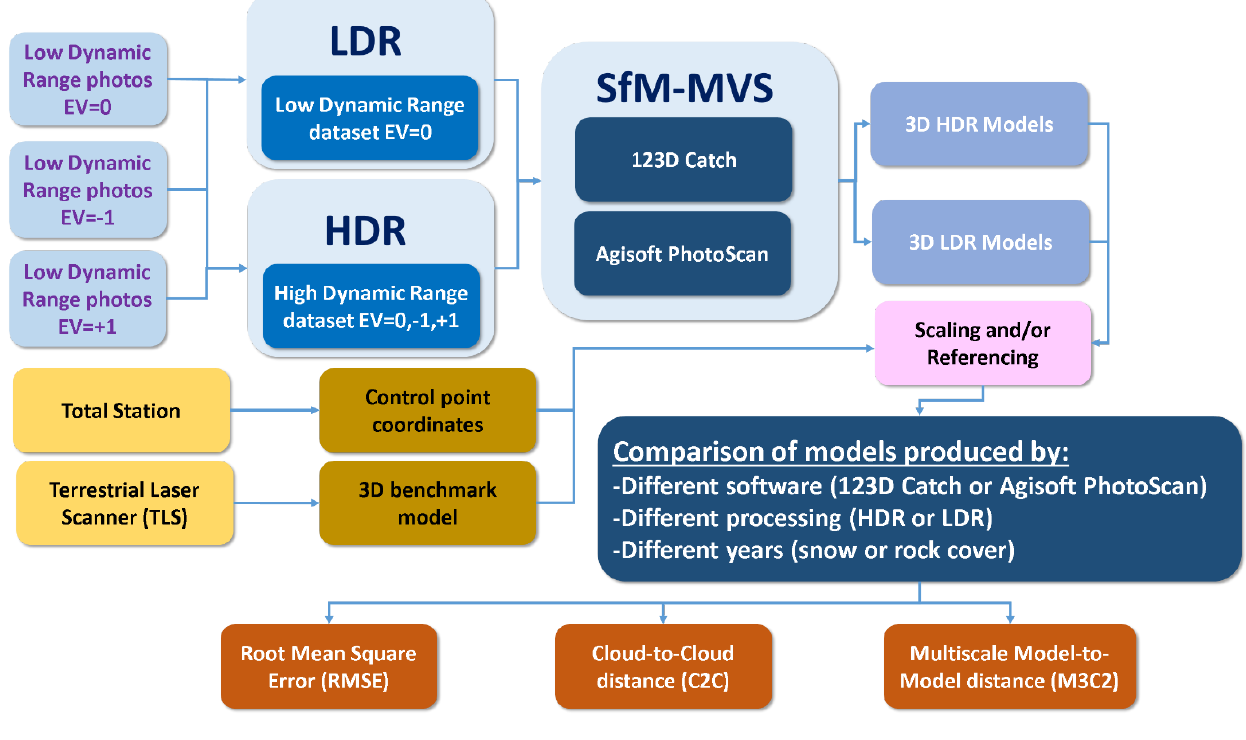
Figure 3. Workflow diagram. EV is Exposition Value, LDR is Low Dynamic Range, HDR is High Dynamic Range and SfM-MVS is Structure-from-Motion